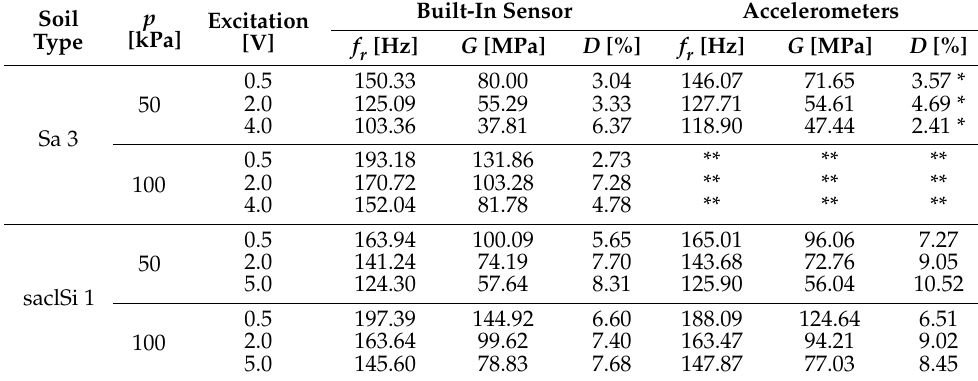
Table 2. Comparison of the obtained results 1